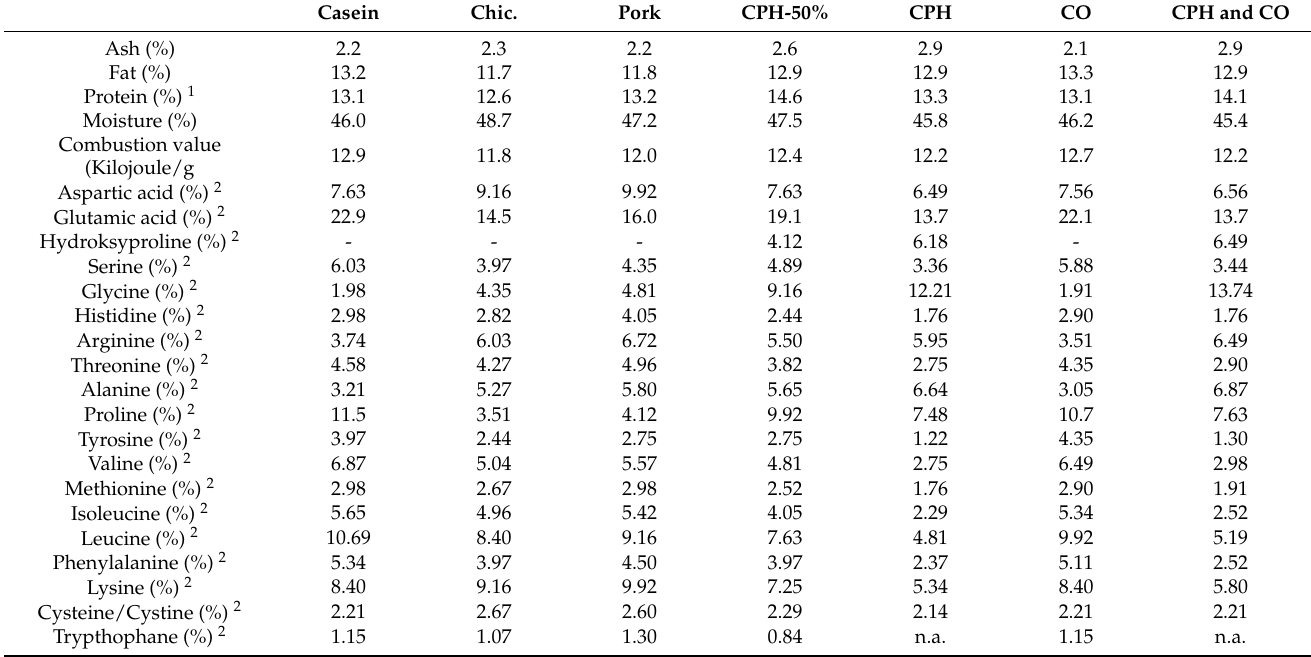
Table 3. Analysis of ash, fat, protein, water, energy, and amino acid composition, in high-fat diets with different protein or lipid